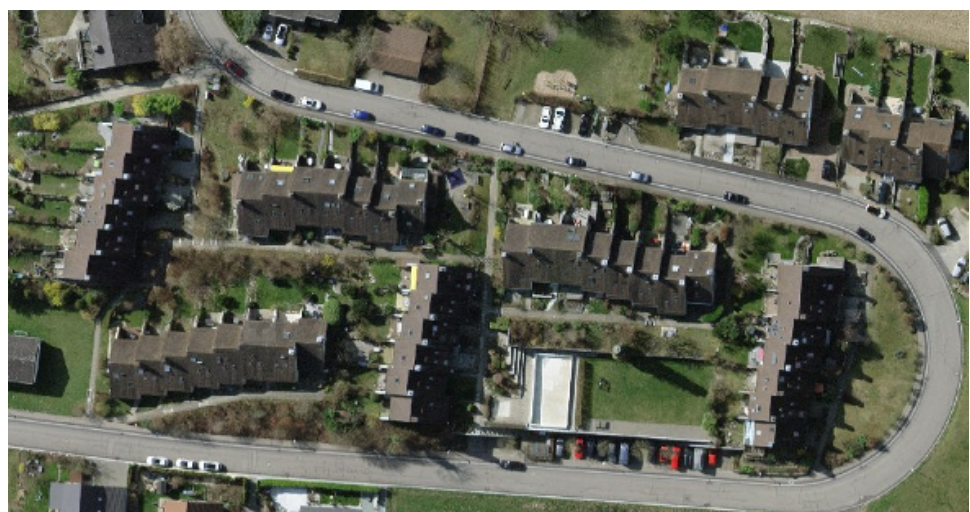
Figure 1. The settlement seen from above with eight building blocks containing 51 row